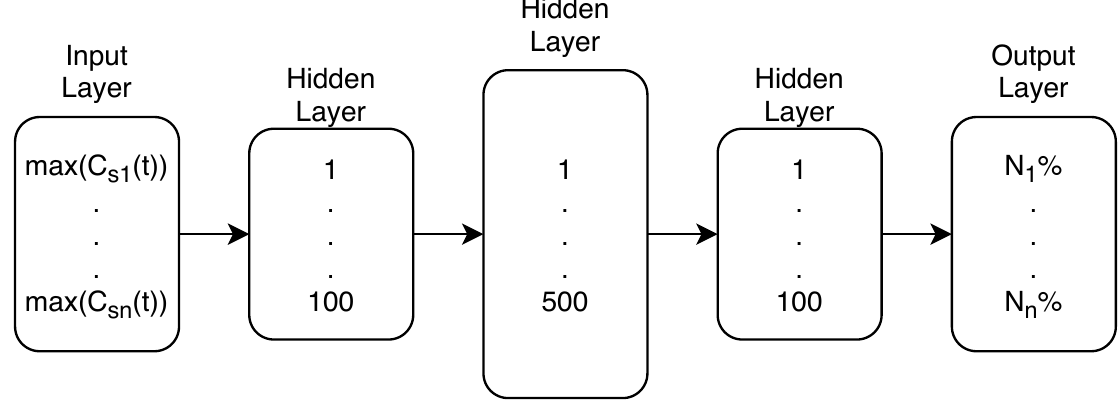
Figure 4. MLP with all